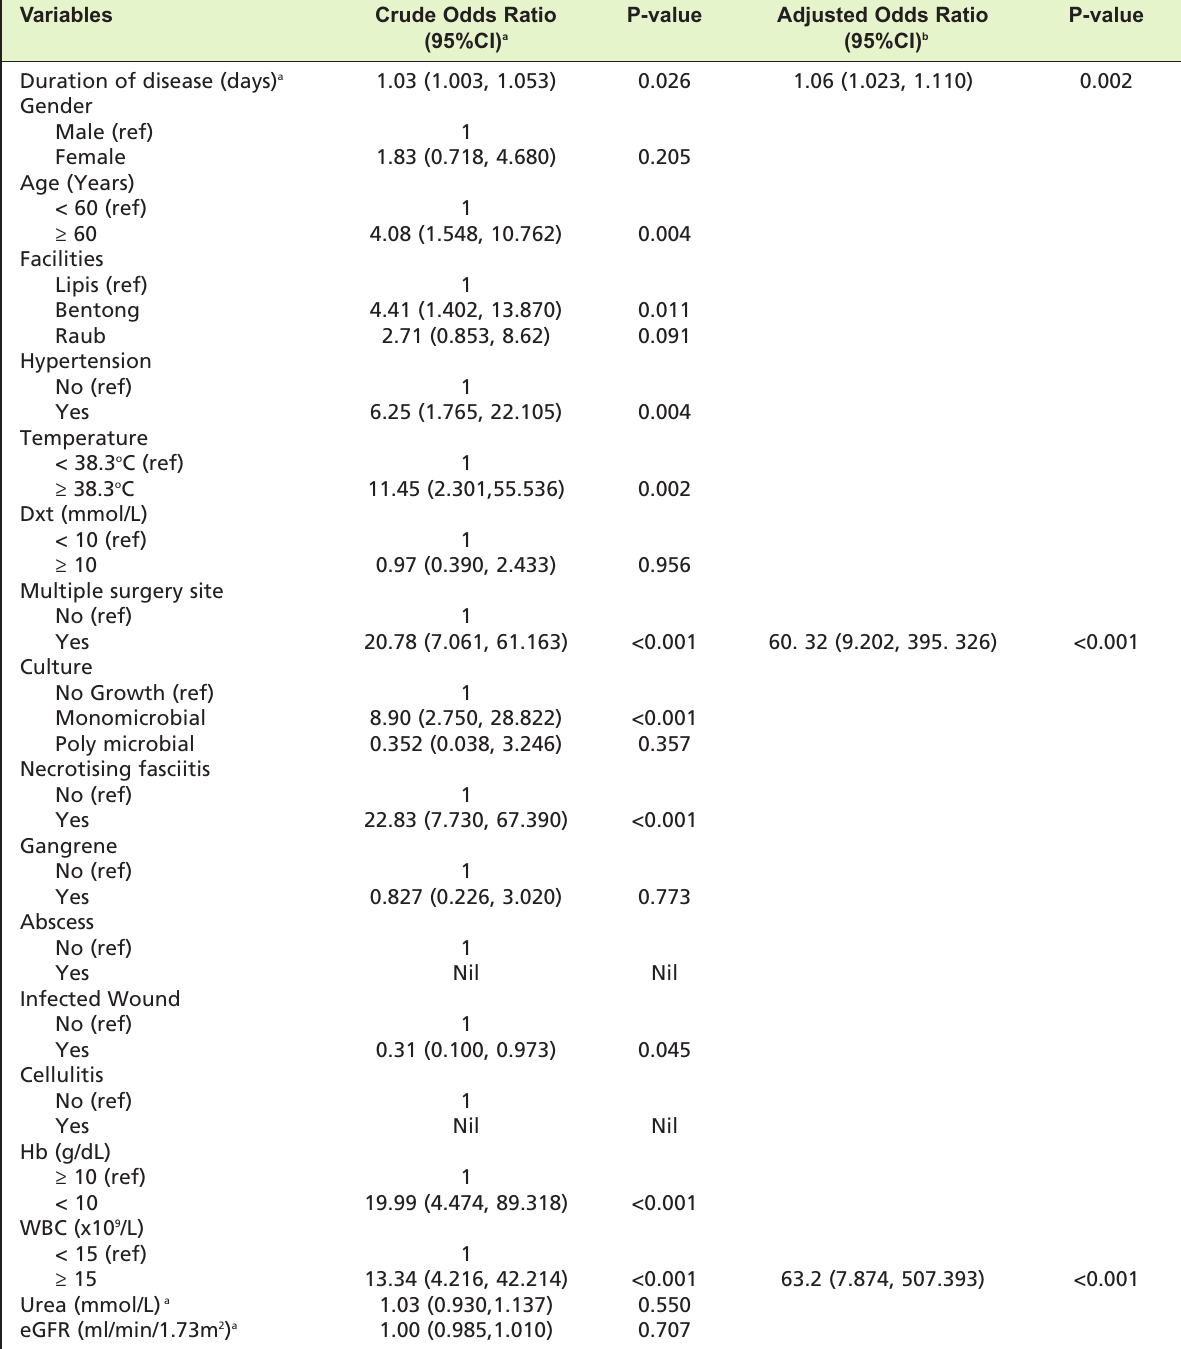
Associative risk factors of major surgery Table II: